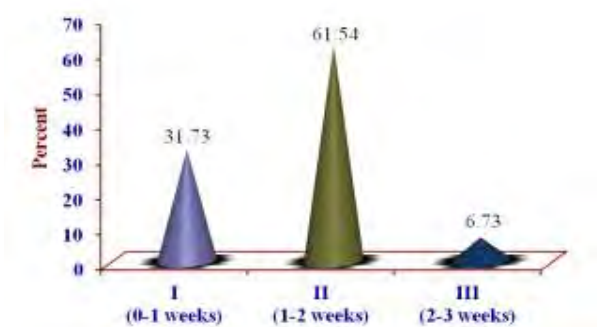
Figure-1. Age-wise distribution of mortality (%) in poultry due to Salmonella infection were subjected to various biochemical tests for